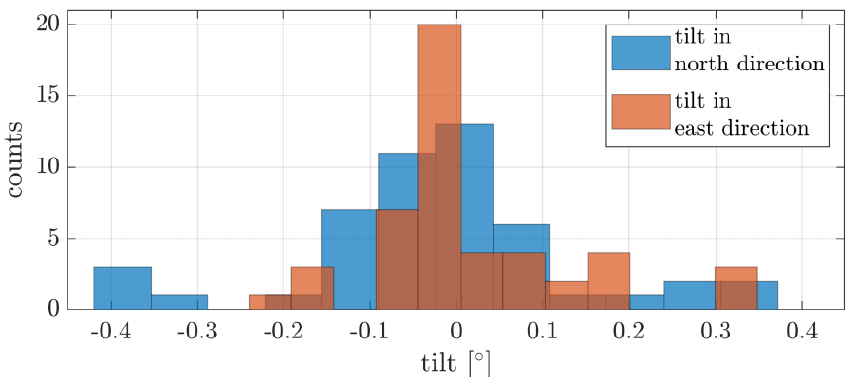
Figure 13. Tilt of planes estimated from UAV point cloud compared to the TLS reference in north and east